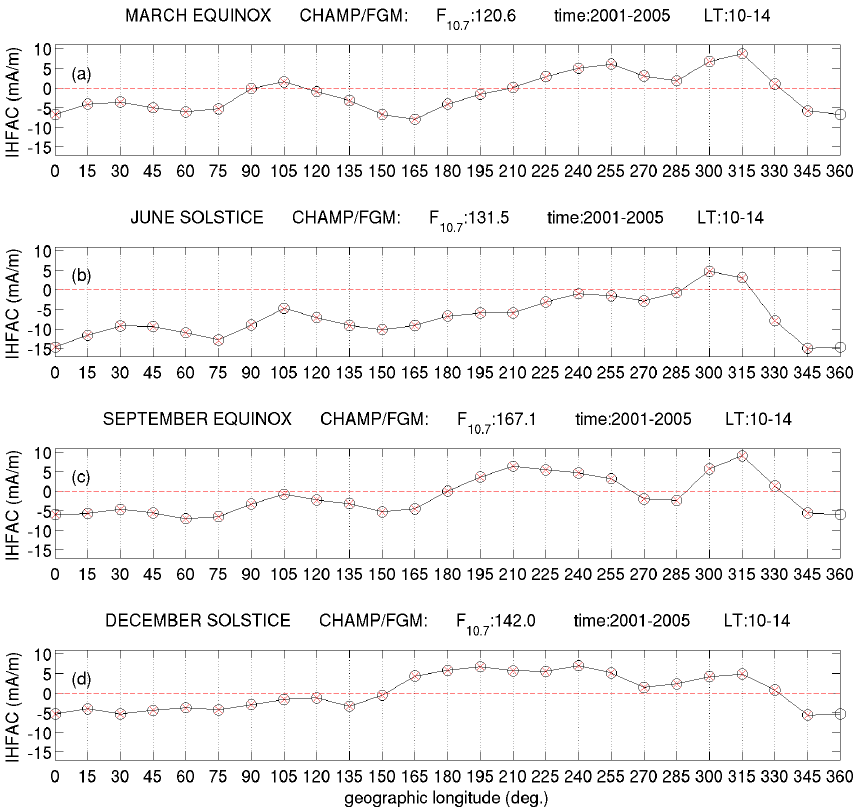
Fig. 3. Longitudinal variation of noontime IHFACs. Each panel corresponds to a season, with the average solar radio flux ( F 10 . 7 ) given in the headings. The standard error of the mean is below 0.5mAm − 1 for each point due to the large number of observations (1600–4900 per